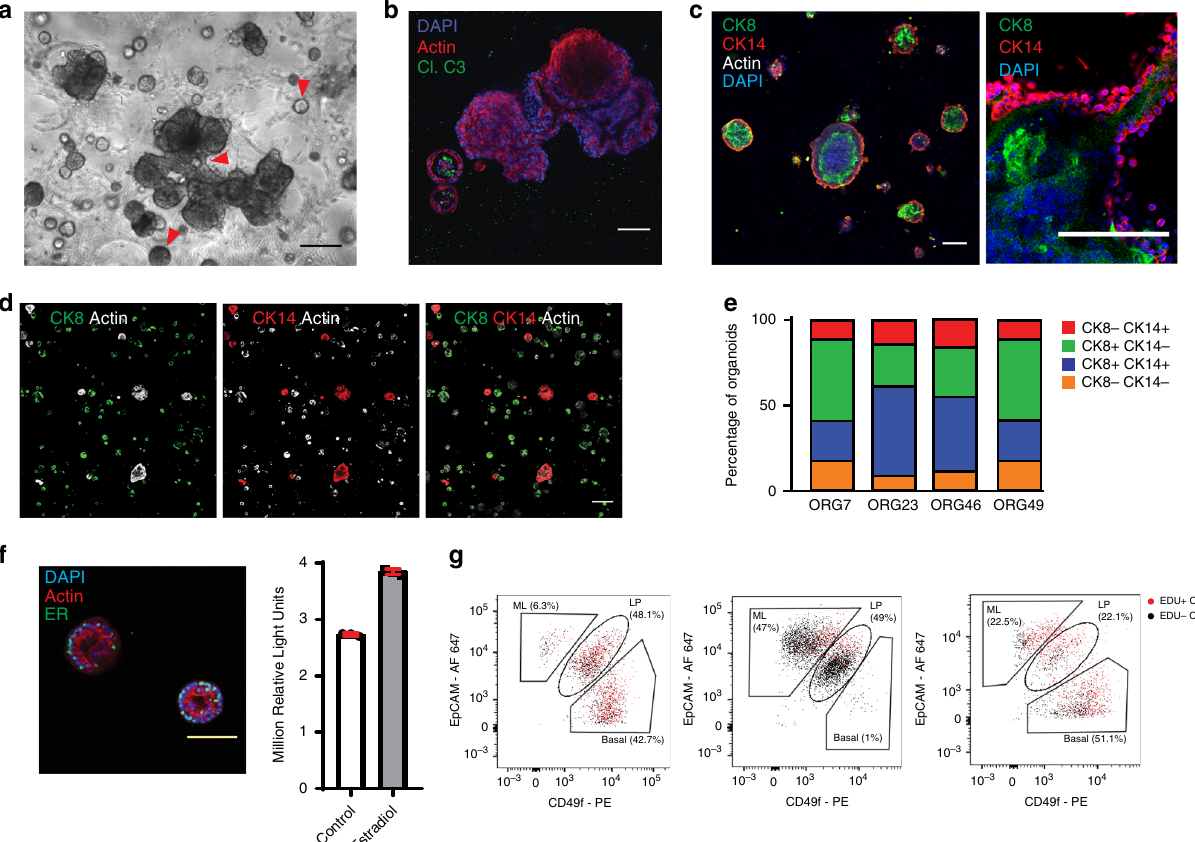
Fig. 1 Human mammary epithelium can be propagated without immortalization as organoid cultures. a Human mammary tissue was digested and cultured in BC organoid medium as previously described 4 . A culture exhibiting multiple organoid structure types (indicated by red arrowheads, representative of n = 79) was imaged by phase contrast microscopy, scale bar = 100 µ m. b , c Organoids were stained as indicated for actin (red) and cleaved caspase 3 (green) to demonstrate clearance of a lumen, or stained for CK8 (green), CK14 (red), and actin (white), and counter-stained with DAPI (blue), n = 4, scale bar = 100 µ m. Organoids were imaged by confocal microscopy. d Low magni fi cation confocal images for a representative culture are shown, n = 4, scale bar = 100 µ m. e Quanti fi cation of organoids positive for CK8 and/or CK14 in each of four normal mammary cultures. f Organoids were stained for ER α (green), actin (red), and DAPI (blue) and imaged by confocal microscopy (left panel, scale bar = 100 µ m). Organoids were treated with 0.5 ng/ml estradiol for 7 days, and organoid viability was assayed using Cell-Titer-Glo (right panel). Mean and standard deviation are shown (ORG9, n = 3). g Three representative organoid cultures (ORG45, ORG9, and ORG24) were stained with EpCAM and CD49f, and these markers as well as EDU incorporation were measured using fl ow